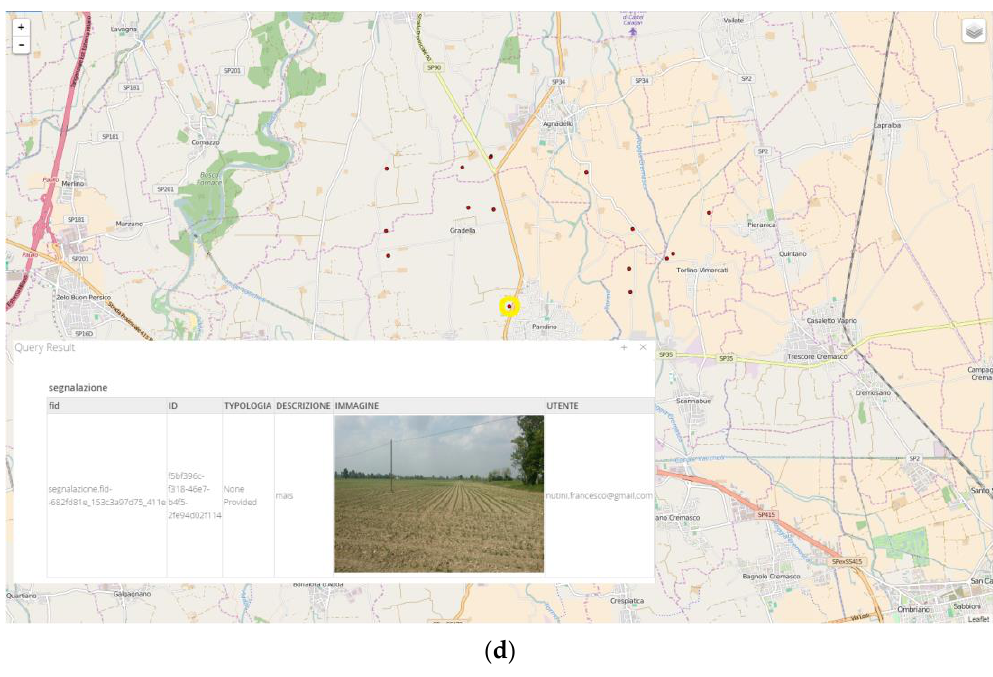
Figure 7. Example of VGI reports created with the S4A Smart APP and automatically published as WMS layers and WFS features. ( a ) screenshots of the S4A Smart APP: the top center panel shows the main menu depicting six icons associated with the possible choices of VGI reports one can create (a picture; a free textual annotation; one can send locally stored VGI items previously created; a crop sowing date; a BBCH stage; an agro-practice observation); the other panels show the lower level menus of the APP for the distinct types of VGI reports. Distinct layers of VGI reports: ( b ) crop typologies, ( c ) agro-practices, ( d ) free textual annotations and pictures, respectively. (Source: own processing).